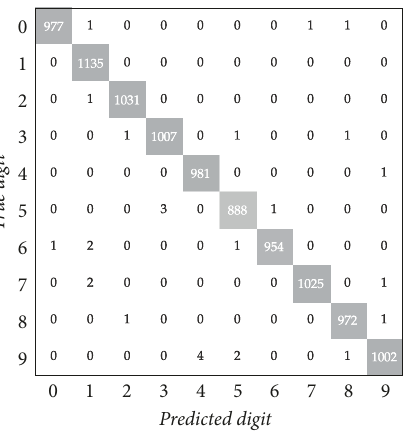
Figure2:ConfusionmatrixofthebestcommitteefoundforMNIST. Figure 3: The 28 misclassified images in the MNIST test set with the best committee